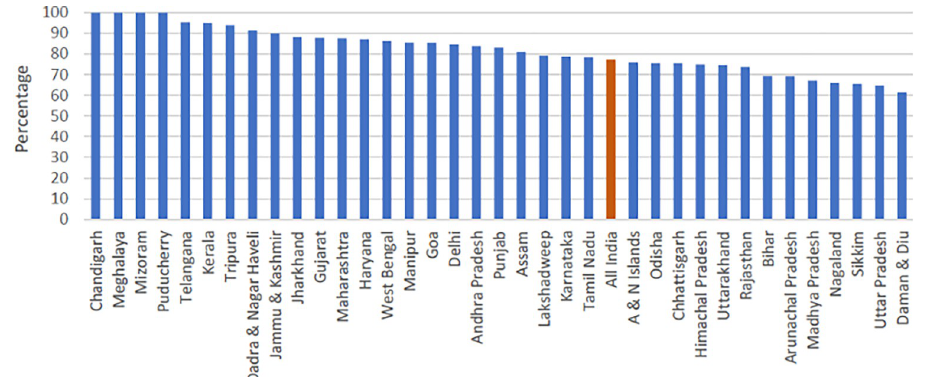
Fig 4. Percentage of reported live births out of estimated live births by states in HMIS, 2017–19.